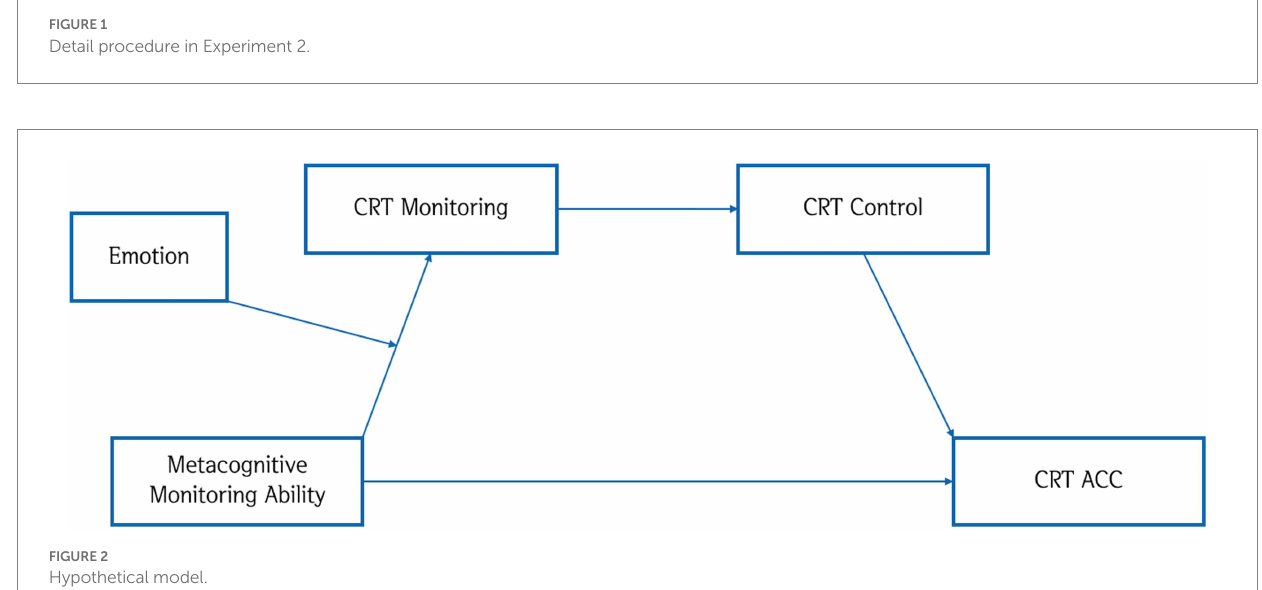
FIGURE 1 Detail procedure in Experiment